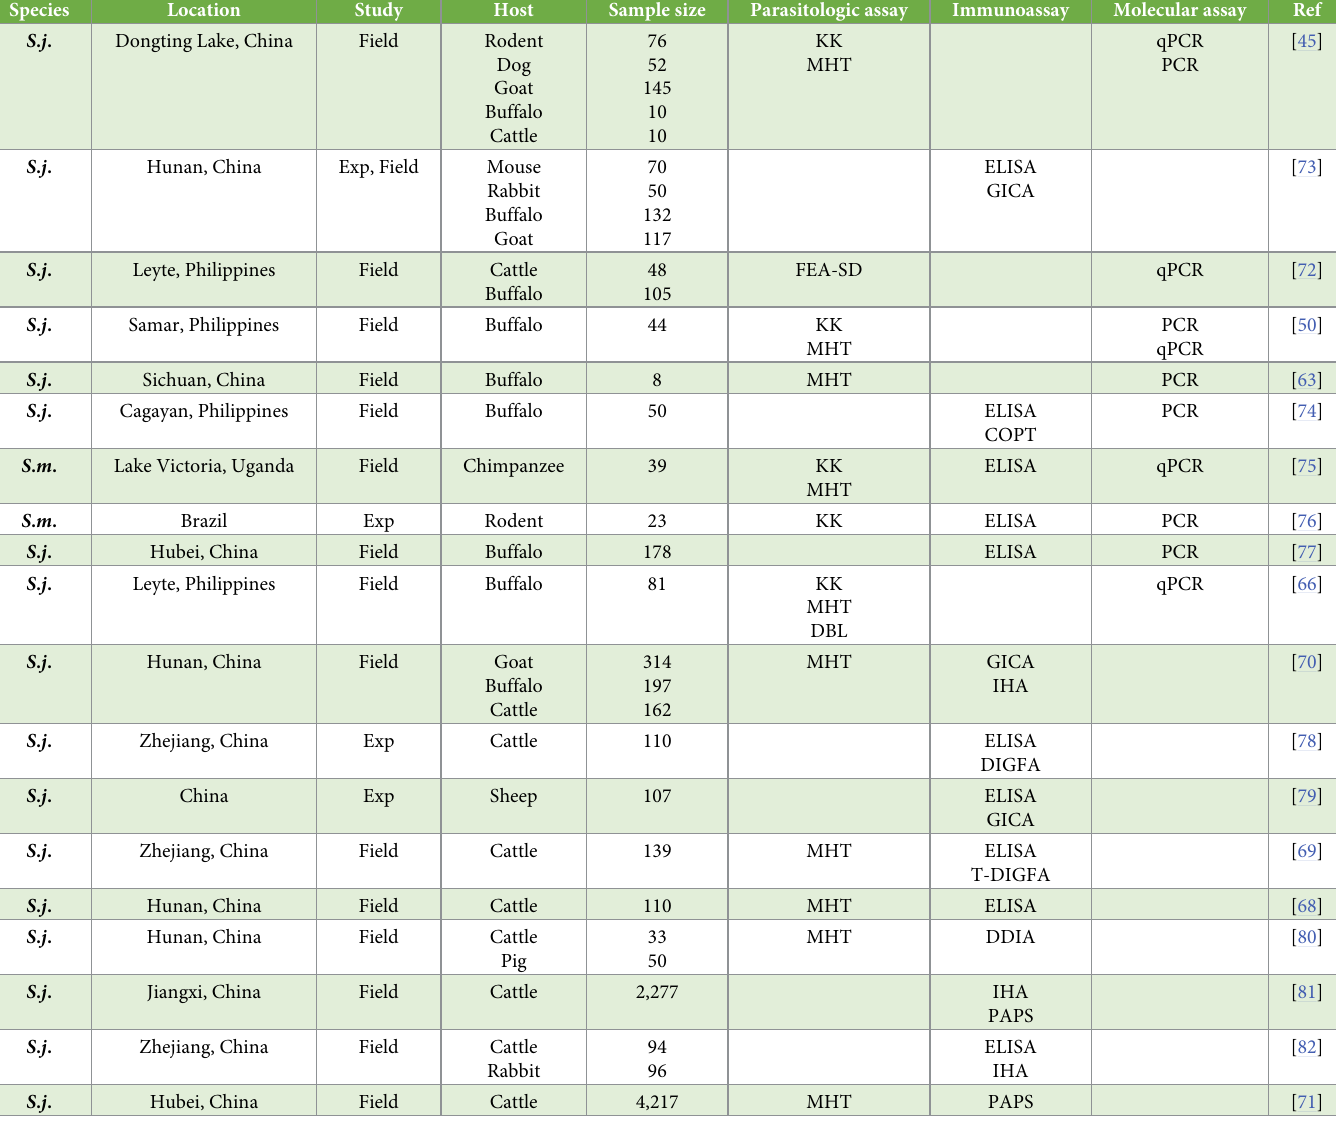
Table 1. Key characteristics of identified studies on diagnosis of schistosome infections in non-human animals.